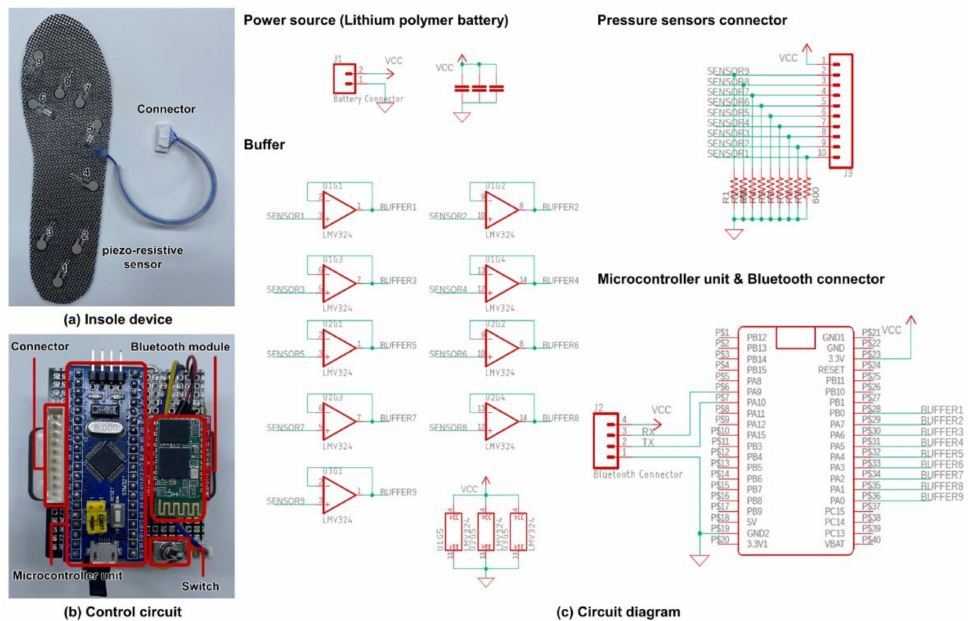
Figure 1. ( a ) Overview of the insole device and placement of the sensors; ( b ) control circuit of the insole system with connector, bluetooth module, microcontroller unit and switch; ( c ) circuit diagram of the custom-designed insole system.